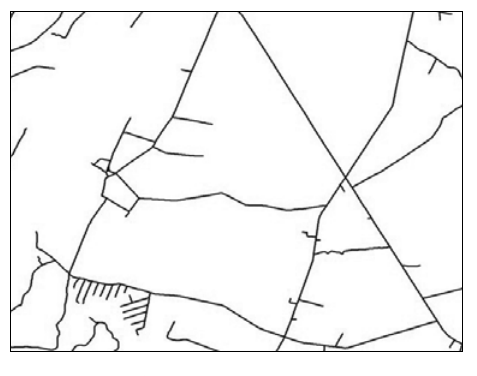
Fig. 3. The information about roads Fig. 4. The information about buildings